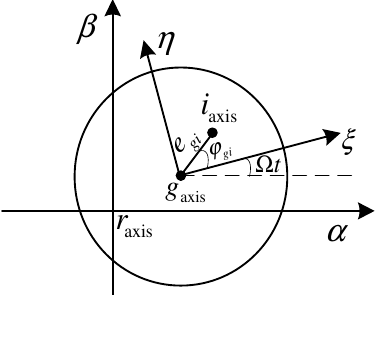
Figure 4. MLR’s rotation axis, geometric axis and inertia axis in the ground and rotor-fixed angular coordinate system.